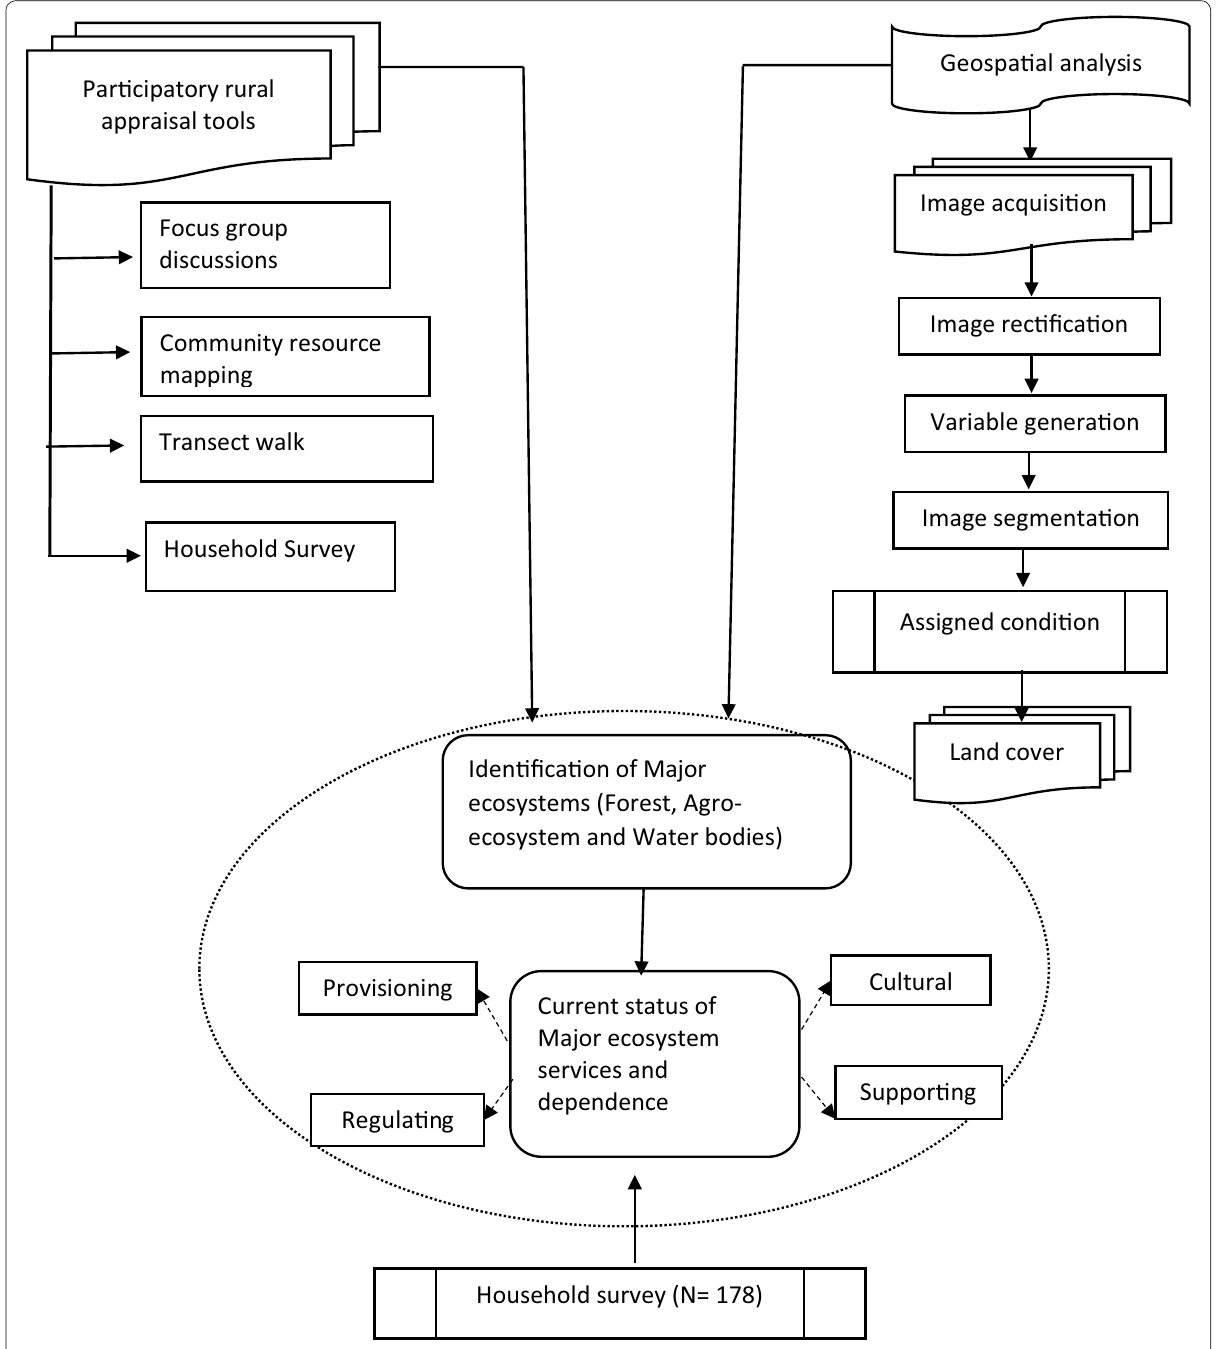
Fig. 2 Overall methodological framework (Source: Adopted and modified from Kandel et al.